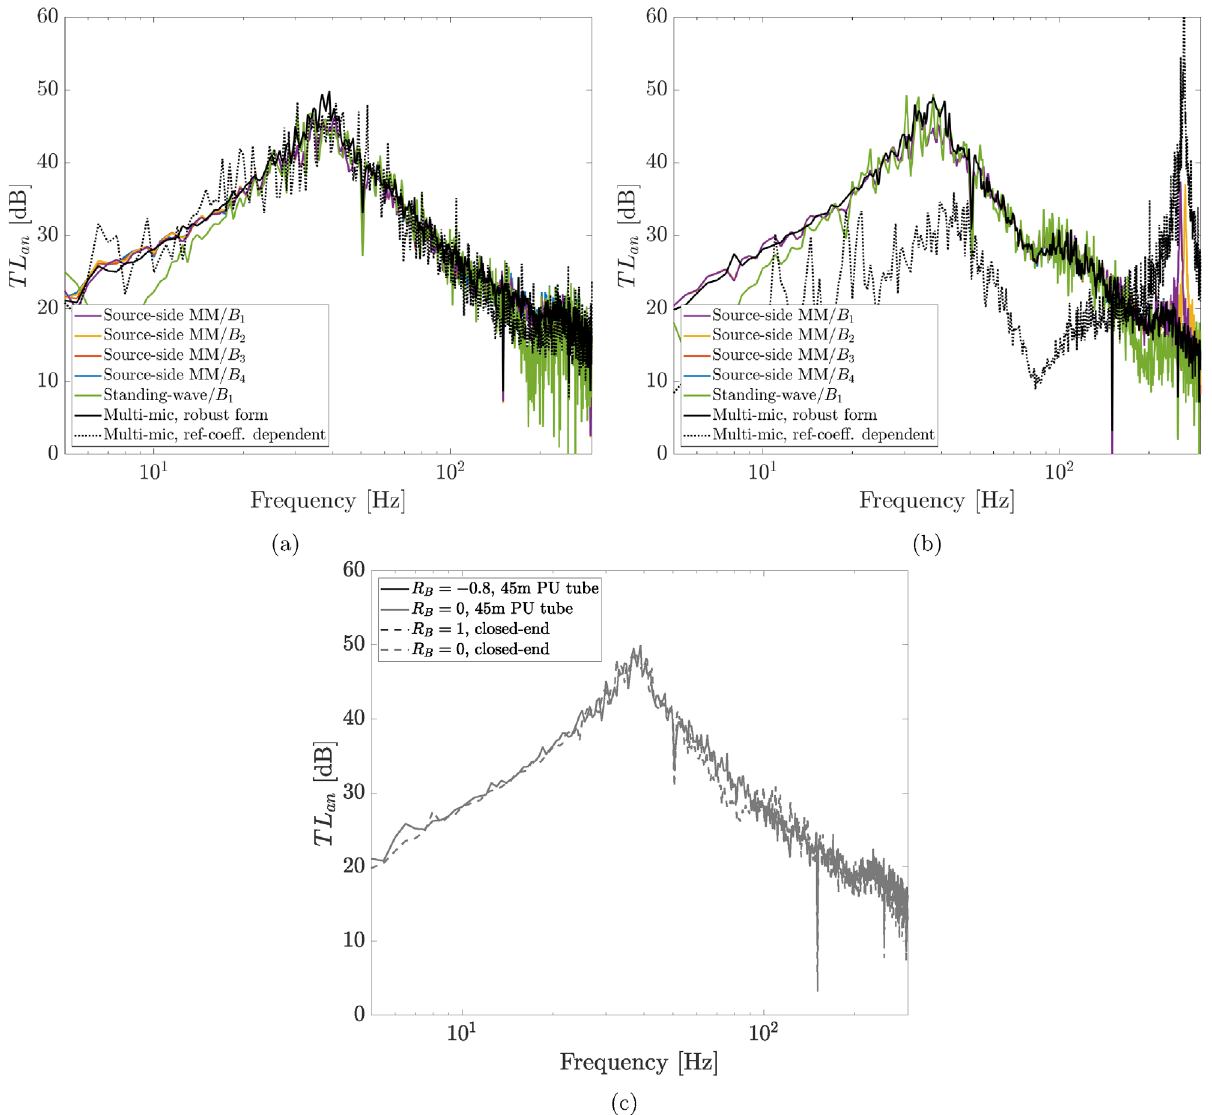
Figure 4. Comparison of measured TL an calculated using source-side multi-microphone, classic multi-microphone method with robust and re fl ection-coef fi cient dependent formulation, and the standing-wave method for fl exible-plate resonator with t plate = 2 mm for (a) the 45 m PU-tube ( R B = (cid:1) 0.8) termination, and (b) the closed-end termination ( R B = 1) on the transmission-side. The effect of error in the estimated re fl ection coef fi cient R B on measured TL an is shown in